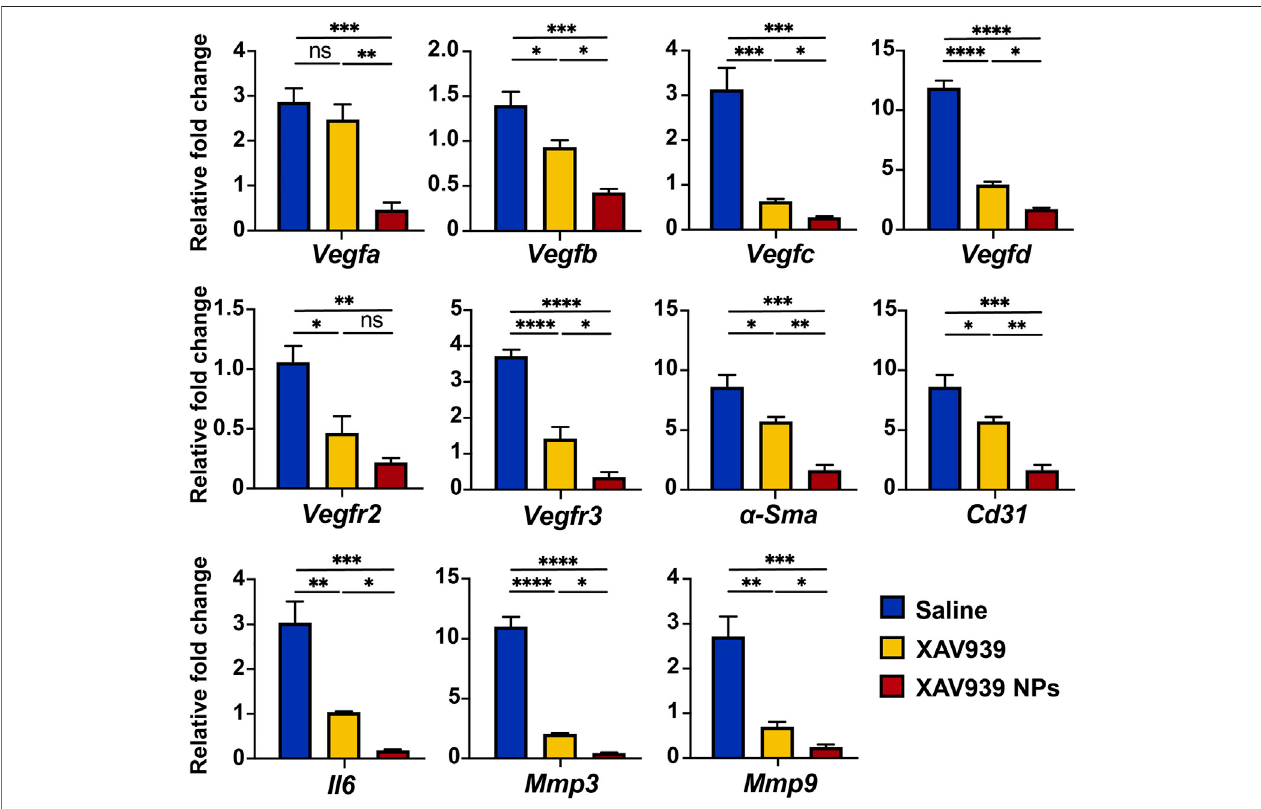
FIGURE 6 | Relative gene expression analyses of Vegfa, Vegfb, Vegfc, Vegfd, Vegfr2, Vegfr3, α -Sma, Cd31, IL-6, Mmp3, and Mmp9 for each group following 14 days of the indicated treatment. Results are presented as the mean ± SEM. n (cid:2) 3 (two corneas served as one biological replica). (One-way ANOVA, * p < 0.05, ** p < 0.01, **** p < 0.0001, ns, not signi fi